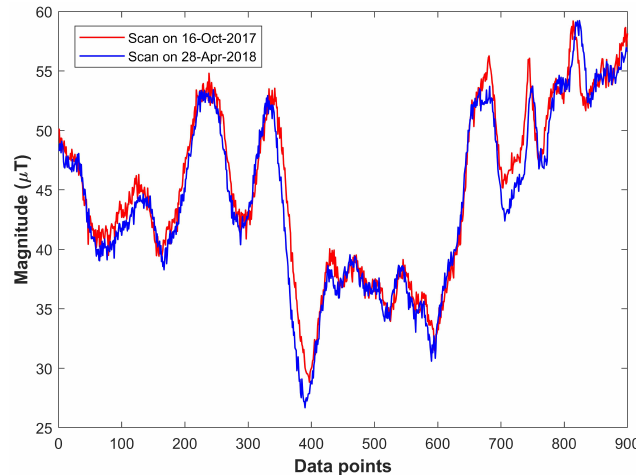
Figure 1. Magnetic intensity values with Galaxy S8 on different dates.